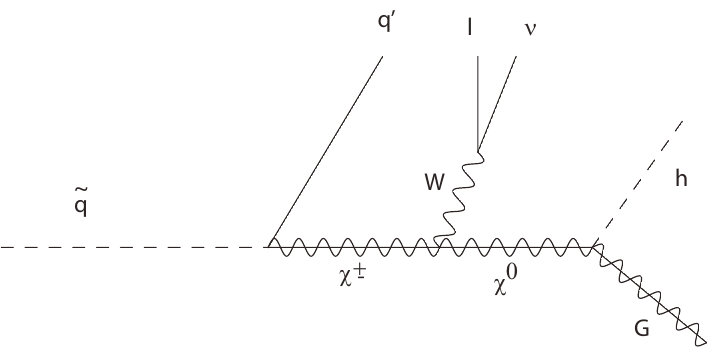
Figure 5 . Decay chain of squark through Higgsino NLSP. Here the NLSP decays to a Higgs and a